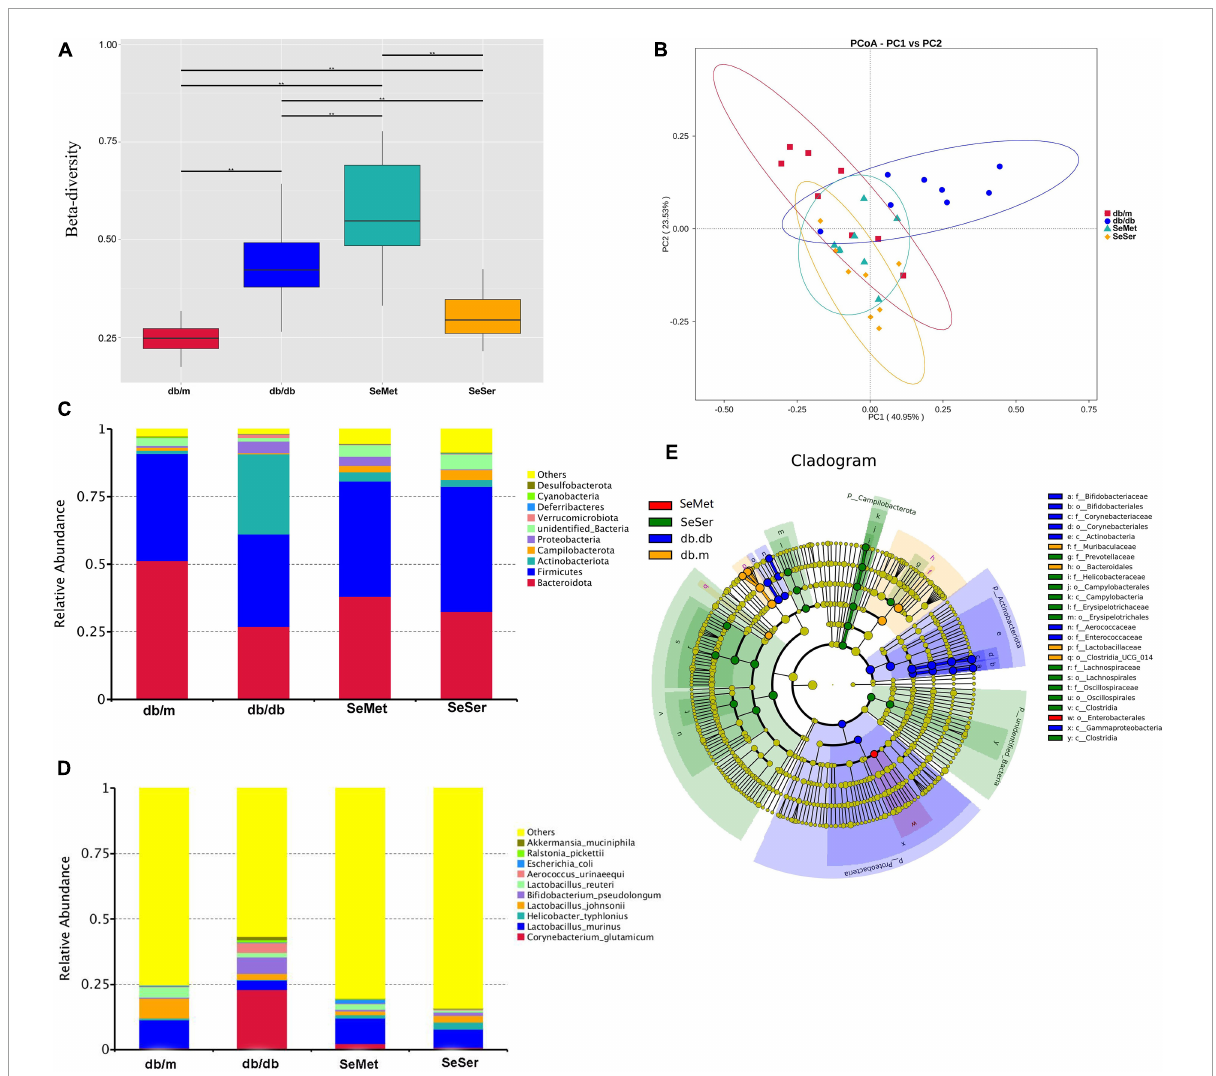
FIGURE4 Administration of selenomethionine and serine altered microbiota composition in db/db diabetic mice. (A) Beta-diversity at the species-level; (B) PCoA plot of themicrobiota based on a weighted UniFrac metric; (C) relative abundance of predominant bacteria at the phylum level; (D) relative abundance of predominant bacteria at the species level; (E) taxonomic cladogram generated from LEfSe of metagenomic sequencing data. Values are expressed as mean ± SEM, n = 8. * P < 0.05, ** P <